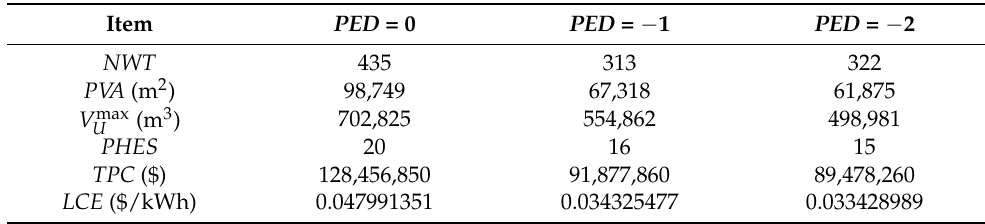
Figure 13. The variations of TPC and LCE along with ±20% change in wind speed.